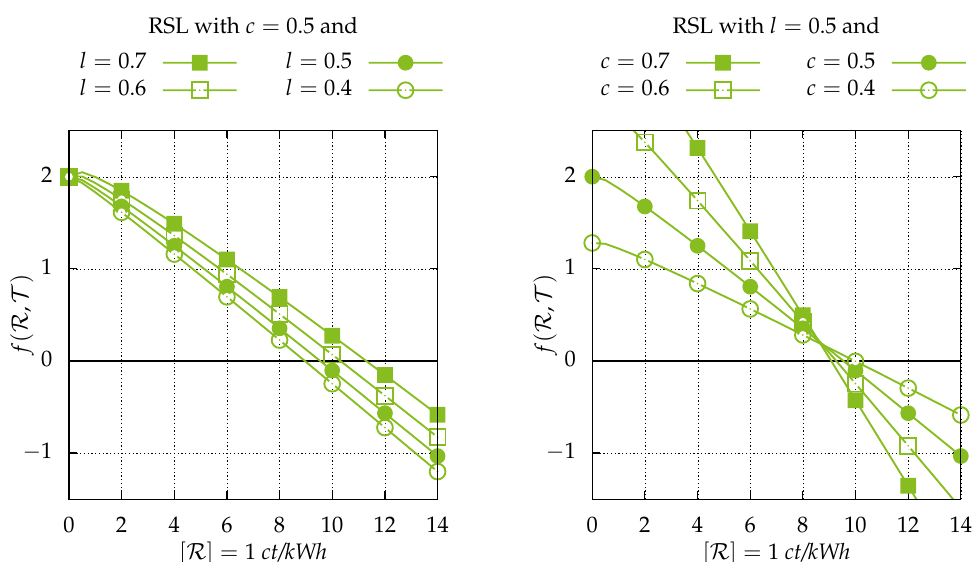
Figure 6. Preference of different RSL types for regional over interregional